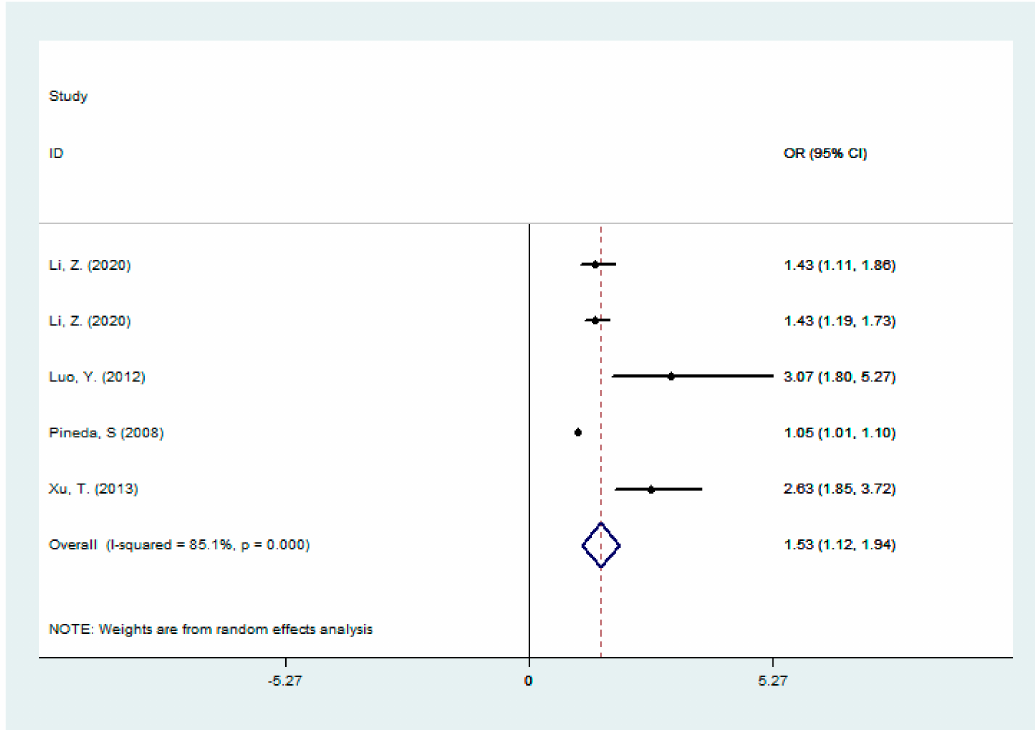
Figure 3. A forest plot of the association between direct bilirubin and stroke severity [7,8,16,20]. For direct bilirubin, indirect bilirubin, and total bilirubin, the weighted mean standard deviation (WMD) was not statistically significant in the two groups of severe ischemic stroke (Table